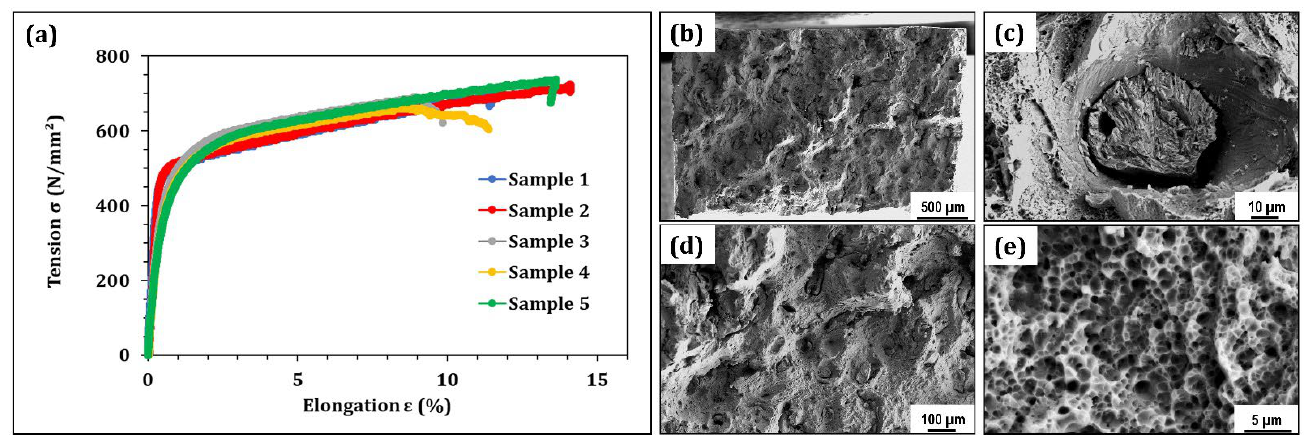
Figure 7. Results of tensile tests: ( a ) Tension elongation diagram of five samples, each represented by a different color; ( b – e ) SEM-SE: fracture area; ( b , d ) cleaved fracture, reduced load-bearing cross-section due to AgCaLa phases; ( c ) brittle fraction of AgCaLa phase; ( e ) ductile fraction of FeMn matrix.